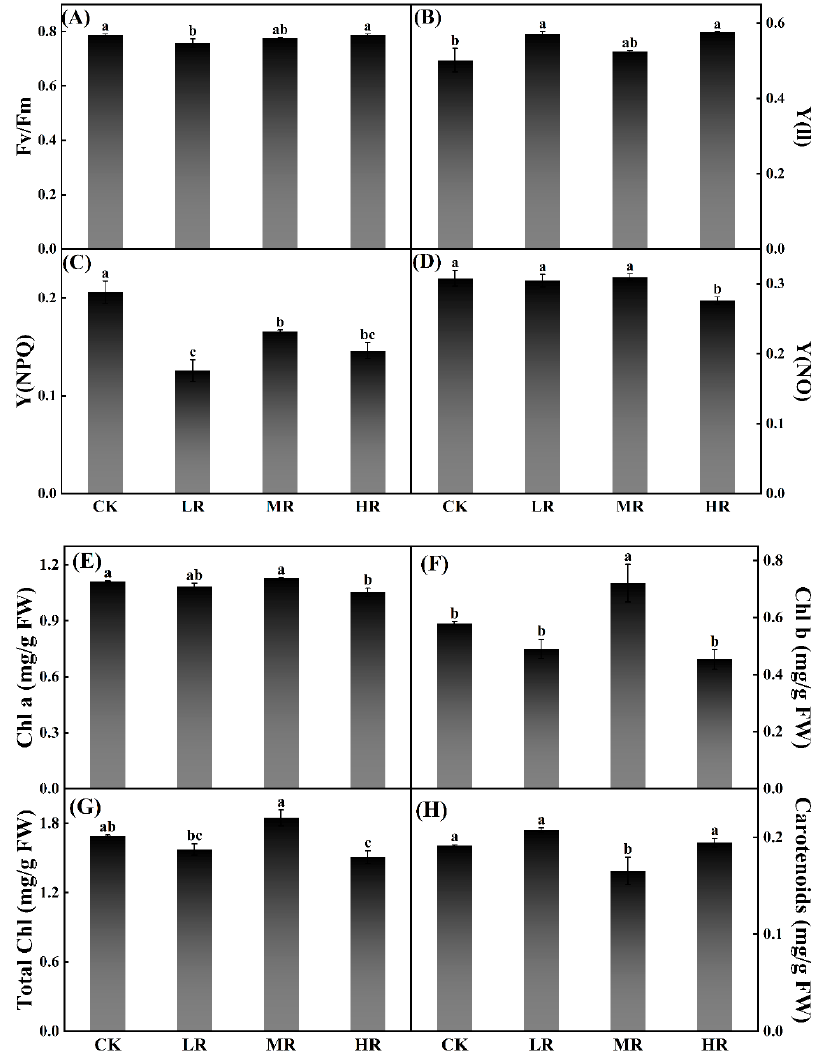
Figure 3. CK: only white light, LR: red:white = 1:2, MR = red:white = 1:1, LR = red:white = 2:1. Maximum photosynthetic efficiency (Fv/Fm) ( A ), photosynthetic efficiency (Y(ll)) ( B ), energy dissipated as fluorescence (Y(NPQ)) ( C ), energy dissipated as heat (Y(NO)) ( D ), and the content of Chl a ( E ), Chl b ( F ), Total Chl ( G ), and Carotenoids ( H ) of pak choi grown under different ratios of red and white light treatments. All values are expressed as mean ± standard error ( n = 3). The letters marked in all figures indicate the significance of the difference ( p ≤ 0.05, Duncan’s test).